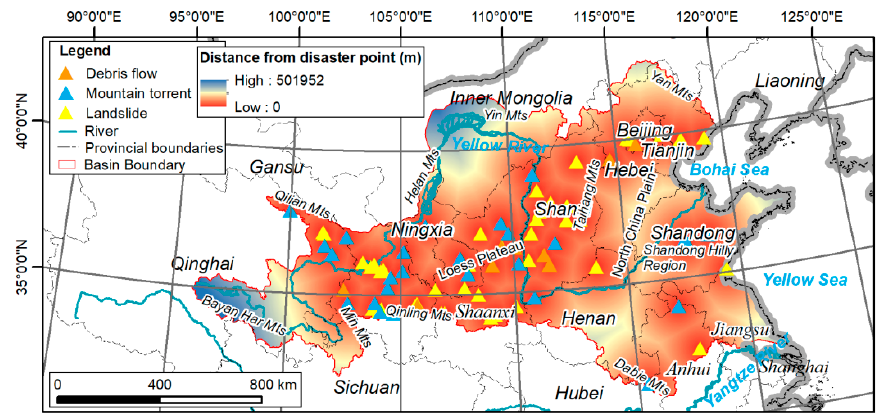
Figure 13. Mountain-hazard distribution and calculation of Euclidean distance around them.